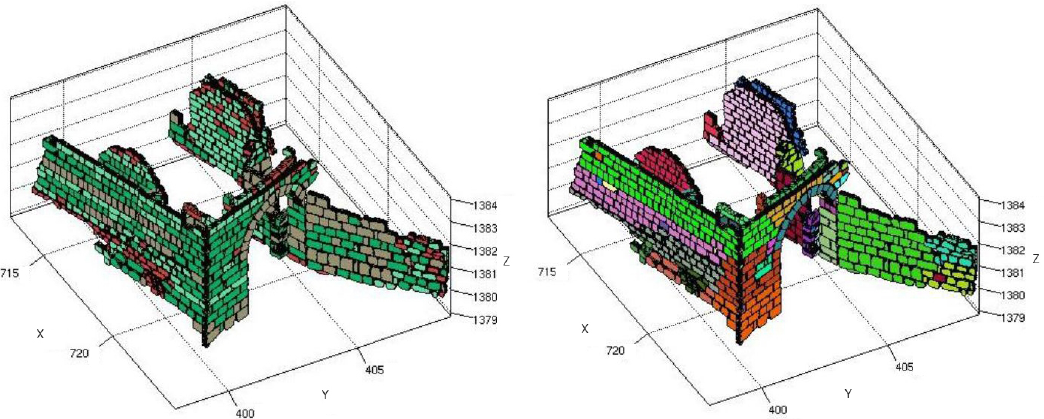
Figure 13. Ashlar block visualization, on the left; the colors show the clusterization result based on the block’s height. Right: the colors show the clusterization result based on